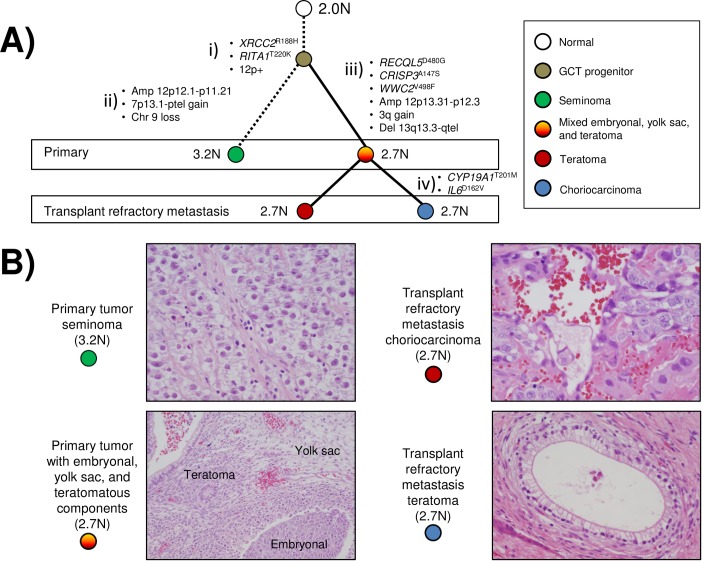
Cell lineage of metastatic TGCT.A) Genomic aberrations within primary and refractory metastatic TGCT in case #1 include; i) shared XRCC2R188H and RITA1T220K mutations in an inferred malignant progenitor; ii) CNVs, 12p13.31-p11.21 amplicon, gain of 7p13.1-ptel, and loss of chromosome 9, that are private to the primary 3.2N tumor seminoma population; iii) mutations RECQL5D480G, CRISP3A147S, WWC2V498F, and CNVs 12p13.31-p12.3, gain of 3q, and deletions of 13q13.3-qtel, private to the 2.7N population within the non-seminomatous primary and metastatic tumor; iv) mutations CYP19A1T201M, and IL6D162V, that are private to 2.7N metastatic population. B) Haematoxylin and eosin (H&E) staining and visualization of distinct TGCT histologies within the primary and metastatic tumor tissues.